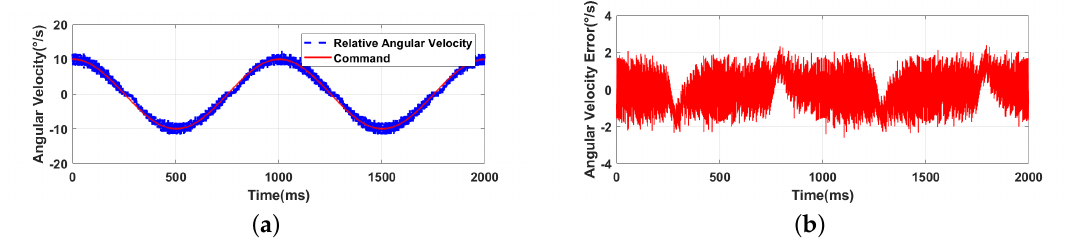
Figure 10. Group B: PI controller u c with a light base support. ( a ) Sine command and relative angular velocity; ( b ) Relative angular velocity